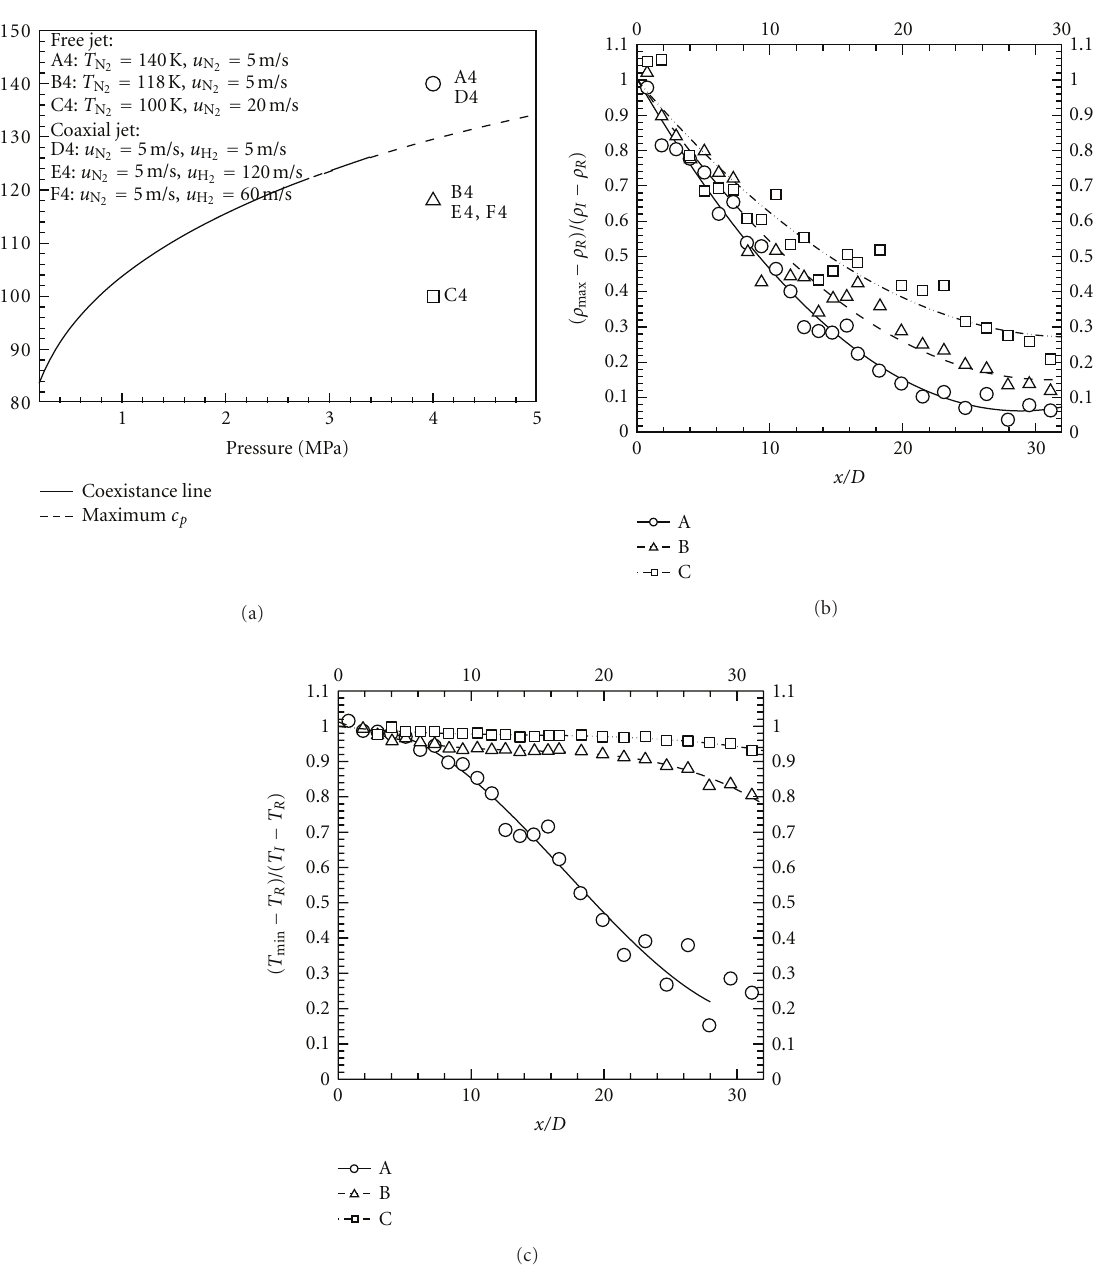
Figure 10: Normalized centerline density (b) and temperature (c) axial profiles of LN 2 injected into GN 2 at three di ff erent injection temperatures and a chamber pressure of 4MPa (i.e., near critical pressure). The plot (a) shows the thermodynamic conditions under which test cases A, B, and C are conducted. The dashed line is the pseudoboiling line. Note, A4, B4, and C4 symbols represent A, B, and C cases, respectively. Oschwald and Schik